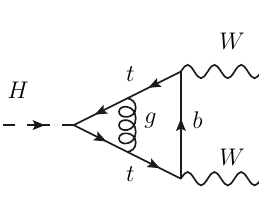
Figure 1 . A typical Feynman diagram contributing to the mixed QCD-EW corrections for the HW + W −